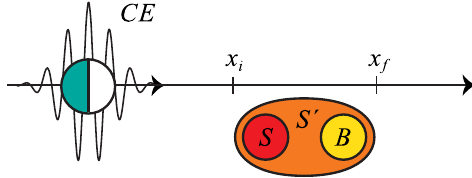
FIG. 7. A control particle that also serves as an energy reservoir. An alternative to the setup in Fig. 6 is a particle that simultaneously serves as both a control system and an energy reservoir. Hence, it is the kinetic energy of the control particle that drives the nonequilibrium process (if the other systems start in equilibrium). This is another example of a system that generally would not satisfy the factorization property (30), but for meas- urement operators Q i þ and Q f þ that are localized outside the CE CE interaction region, the systems become approximately noninter- acting. For this setup, one can obtain an approximate fluctuation relation in terms of the transition probabilities introduced in Sec.